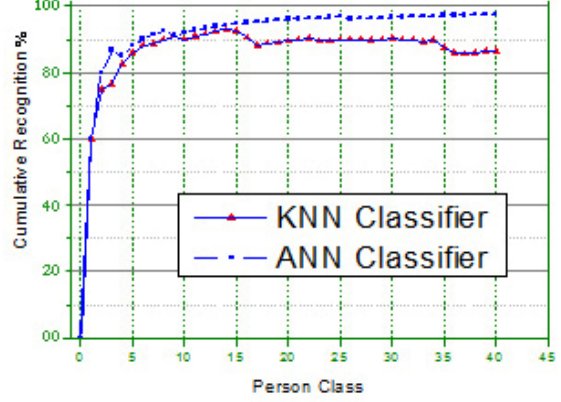
Fig. 11: Face Recognition Performance State Space Feature parameter on AT & T face database using ANN and KNN Classifiers.